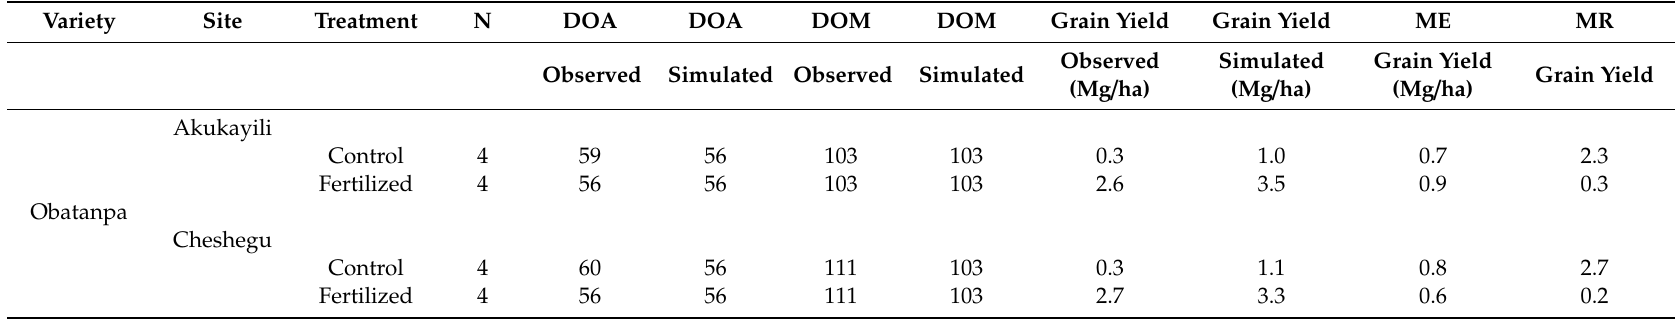
Table 3. Observed and simulated values of grain yield, Aboveground biomass (AGB), Day of Anthesis (DOA), Day of Maturity (DOM), mean residual error (ME), and mean absolute error (MR), N = number of replicates for the maize variety (Obatanpa) in two sites Akukayili and Cheshegu (Ghana). Variety